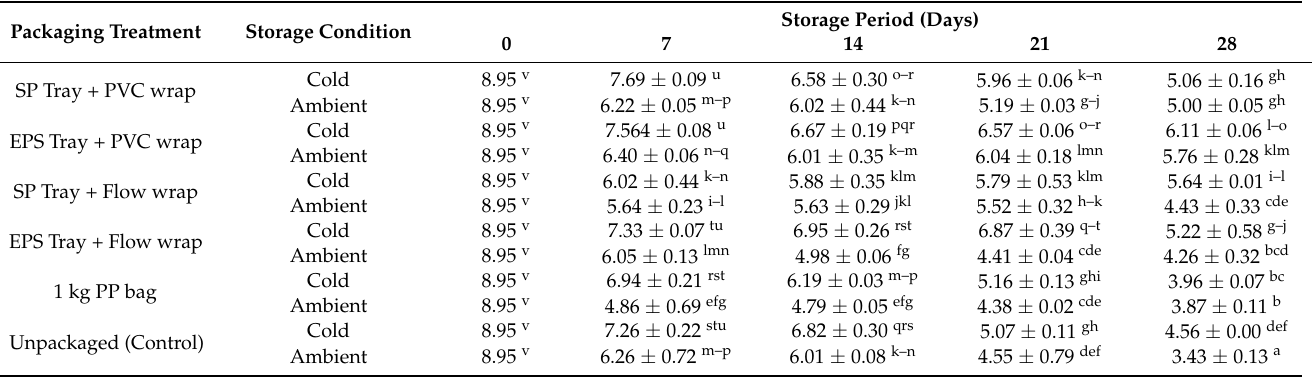
Table 5. The total sugars (mg · 100 − 1 g FW) of tomatoes are influenced by the packaging and storage conditions over the 28-day storage period ( n =